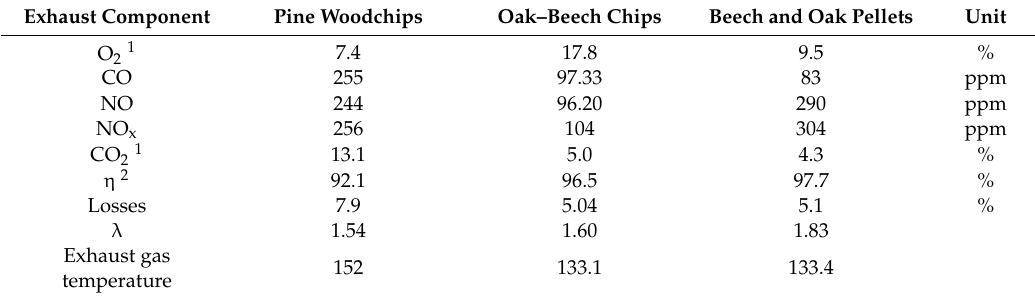
Table 4. Measurement results of the exhaust gas analyzer during combustion of pine woodchips of the fuels investigated.